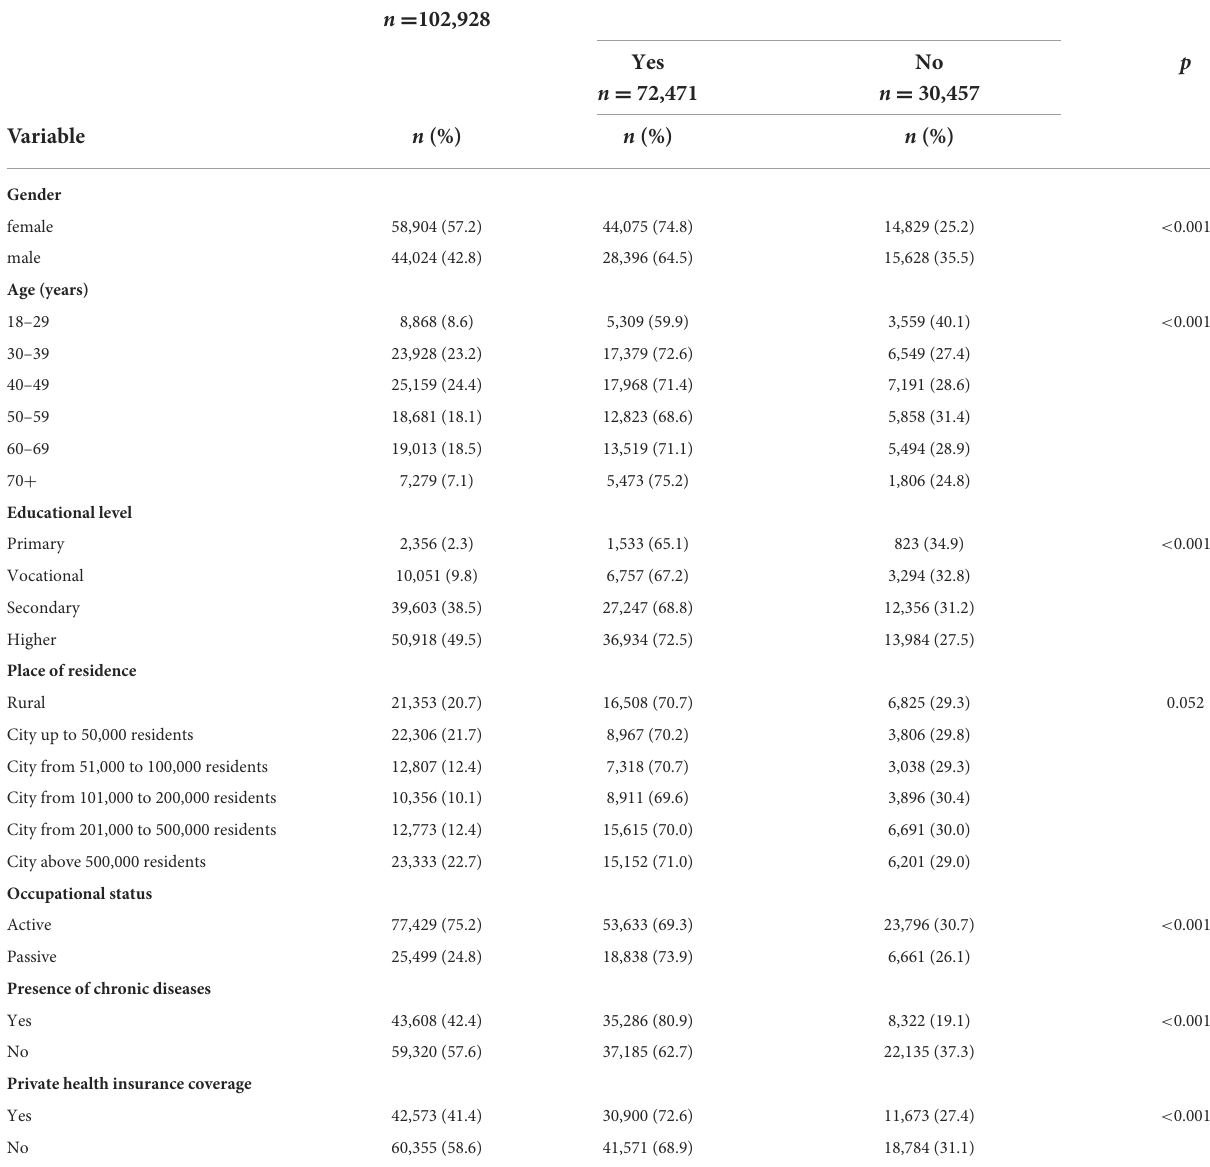
TABLE 1 Characteristics of the study population by visiting a doctor in the past 12 months ( n = 102,928). Total